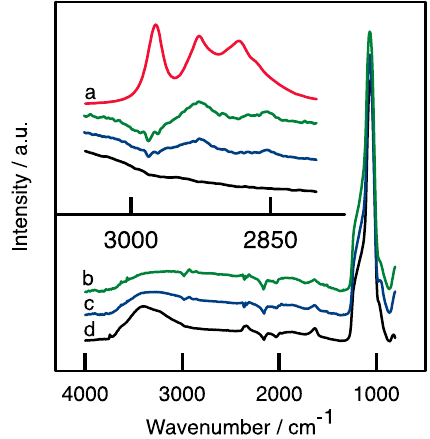
Figure 3. ATR-FTIR spectra of: ( a ) pure APTES ((3-aminopropyl)triethoxysilane); ( b ) TA-A50; ( c ) TA-A10; and ( d ) Si(HIPE). An increase in C–H stretching band absorbance (around 2900 cm − 1 ) suggests a higher amount of aminopropyl groups grafted to monolith surface for higher APTES concentrations.